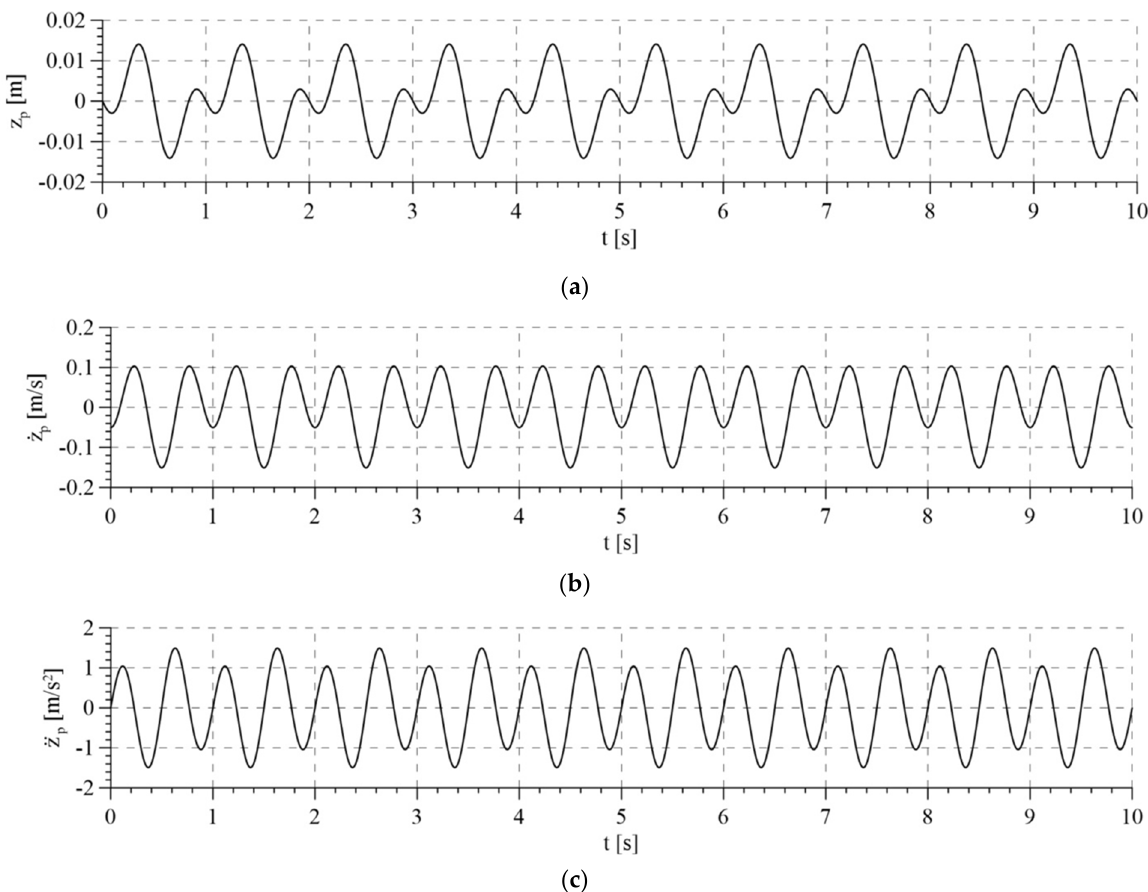
Figure 5. Interferences of the system: ( a ) displacement of torso; ( b ) velocity of torso; ( c ) acceleration of torso.